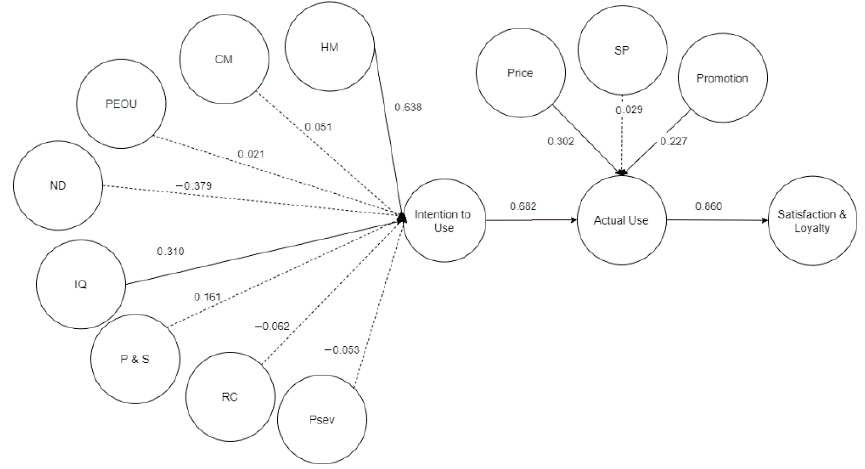
Figure 2. Initial result of SEM.